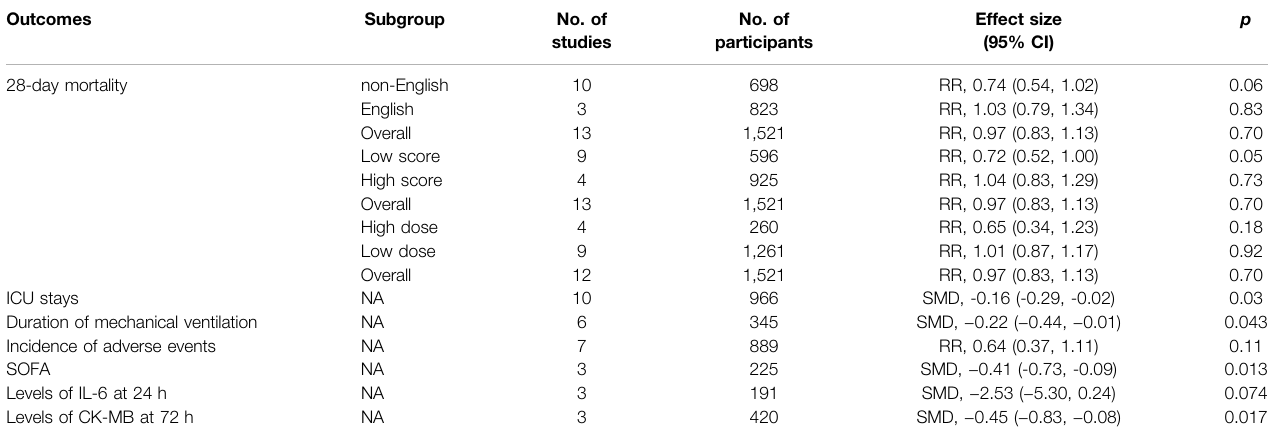
TABLE 2 | Summary of